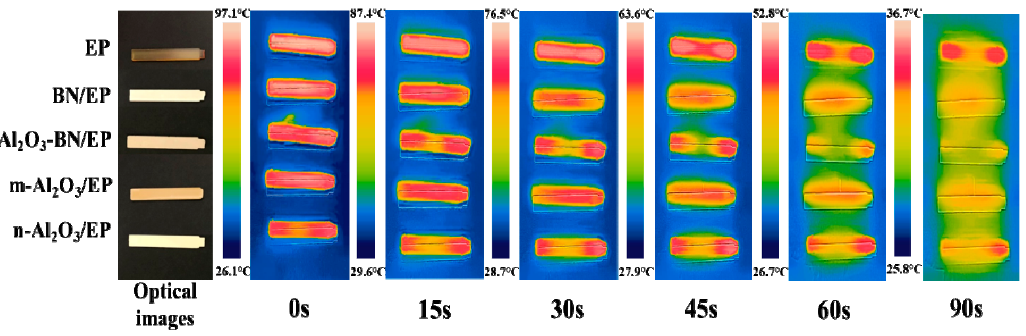
Figure 6. Thermal conductivity of ( a ) the distinct EP composites as a function of filler content and ( b ) m-Al 2 O 3 -BN/EP with 50 wt% as a function of Al 2 O 3 to BN ratio. Thermal diffusivity of ( c ) the distinct EP composites as a function of filler content, and ( d ) m-Al 2 O 3 -BN/EP with 50 wt% as a function of Al 2 O 3 to BN ratio.